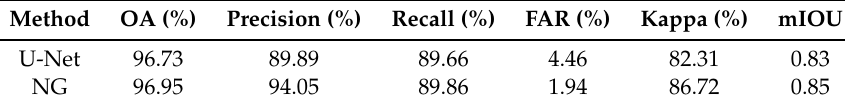
Table 1. Evaluation results with U-Net models and NG models on the test dataset.